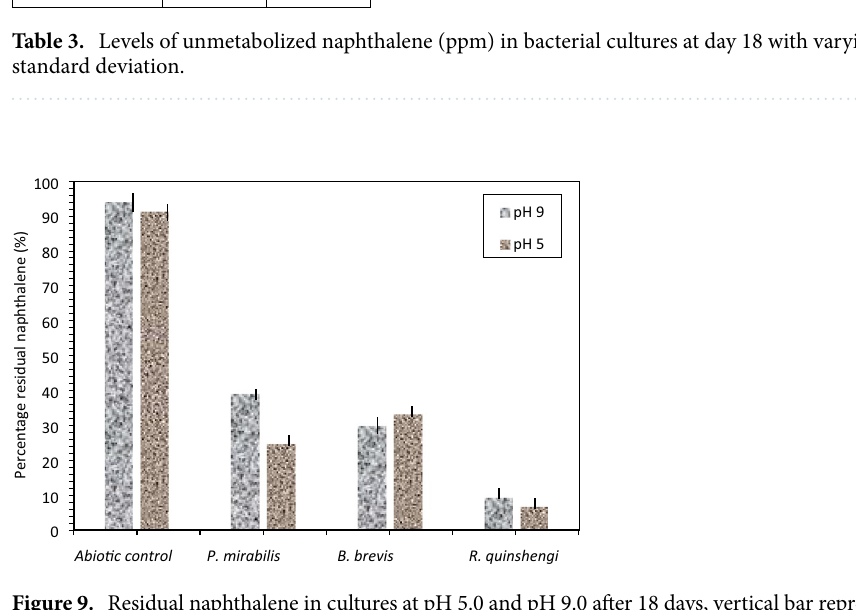
Figure 9. Residual naphthalene in cultures at pH 5.0 and pH 9.0 after 18 days, vertical bar represents error